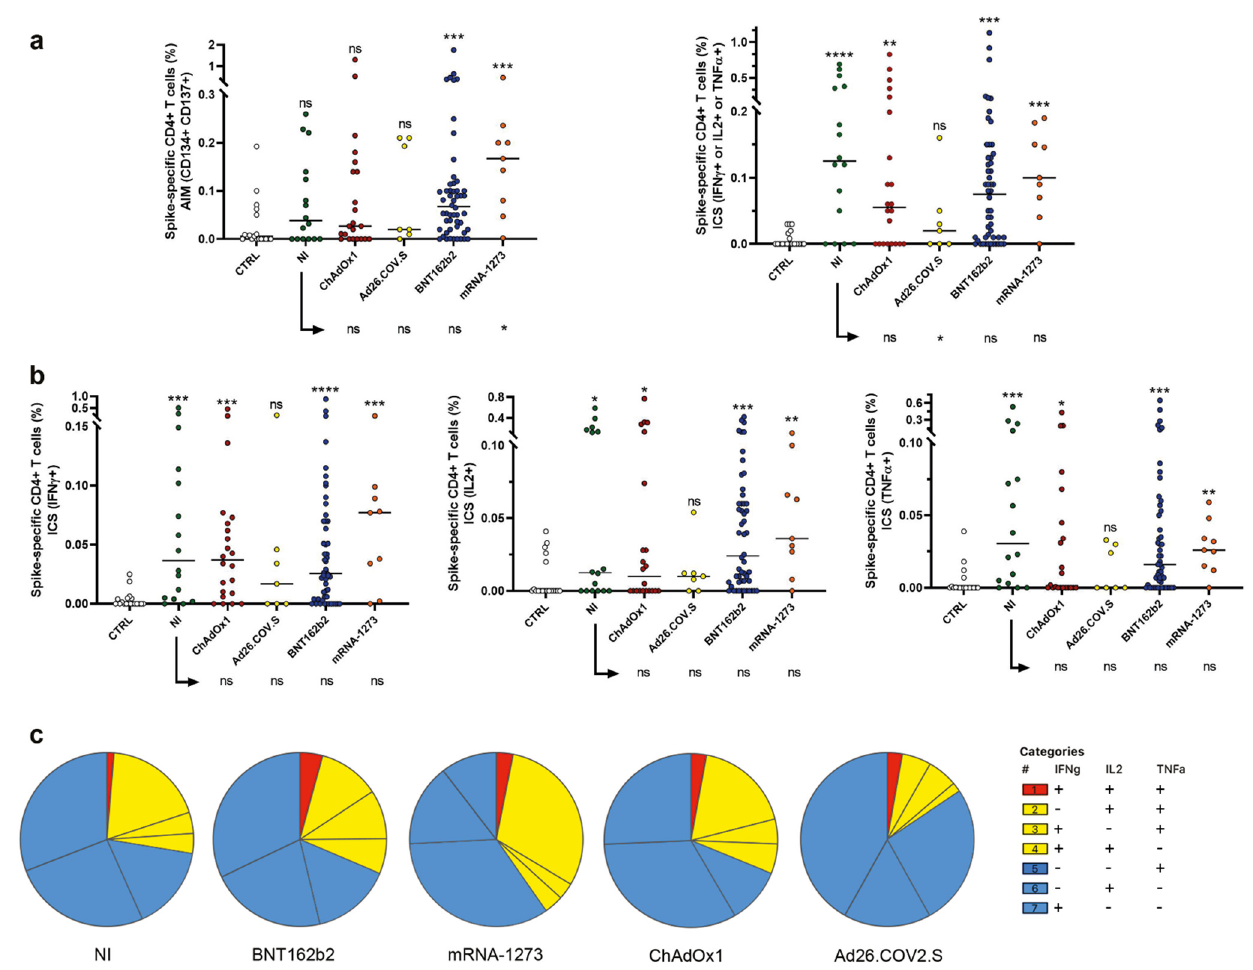
Figure 2. AIM, ICS, and polyfunctionality of spike ‐ specific CD4 + T cells. Frequencies of CD4 + T cells expressing T ‐ cell activation markers ( a ) and producing antigen ‐ specific cytokines ( b ) are shown in SARS ‐ CoV ‐ 2 ‐ unexposed healthy donors who never received any anti ‐ SARS ‐ CoV ‐ 2 vaccine (CTRL), in resolved natural infections (NI), and in donors vaccinated with two doses of ChAdOx1, a single dose of Ad26.COV2.S, and two doses of BNT162b2 and mRNA ‐ 1273 vaccines. Frequencies were obtained by subtracting to the values of the stimulated samples the background produced by the related unstimulated tube. Individual data points are represented as scatter dot plots with lines showing the median value. ( c ) Pie charts show the expression of cytokine combinations from CD4 + T cells following spike stimulation. Significance was calculated using nonparametric Mann– Whitney U ‐ tests (two ‐ tailed). A p ‐ value <0.05 was considered statistically significant. [ns ( p > 0.05),